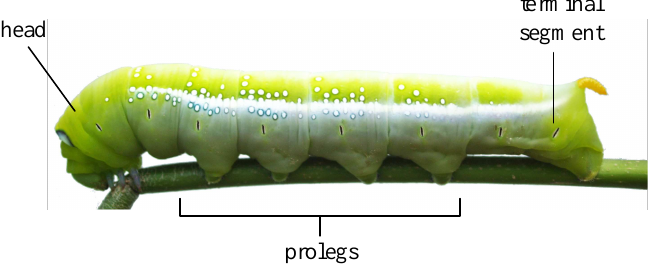
Figure 1. Caterpillar